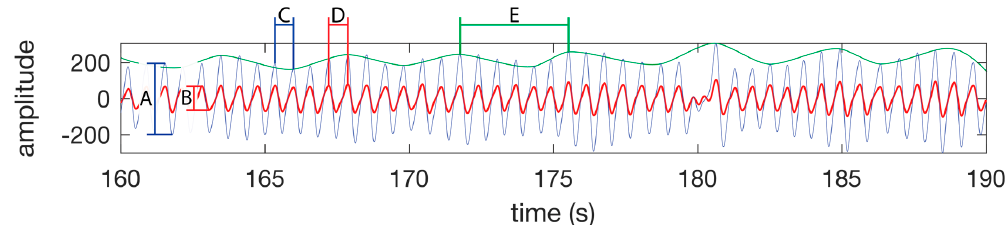
Figure 5. PPG waveform features. SpO 2 is calculated using the amplitude of the IR waveform (A) and the amplitude of the red waveform (B) as per the equation (1). (C) A single heart beat in the IR waveform. (D) A single heart beat in the red waveform. The time between peaks of a heat beat on a single channel is used to calculate the instantaneous heart rate. (E) A single respiration as seen as a change in amplitude of the IR or red waveform. The time between the peaks is used to calculate the instantaneous respiration rate. The green line is not part of the PPG waveform, but is presented in this figure to highlight the respiration component of the PPG waveform. The waveform was taken from the test subject 1 dataset while walking.